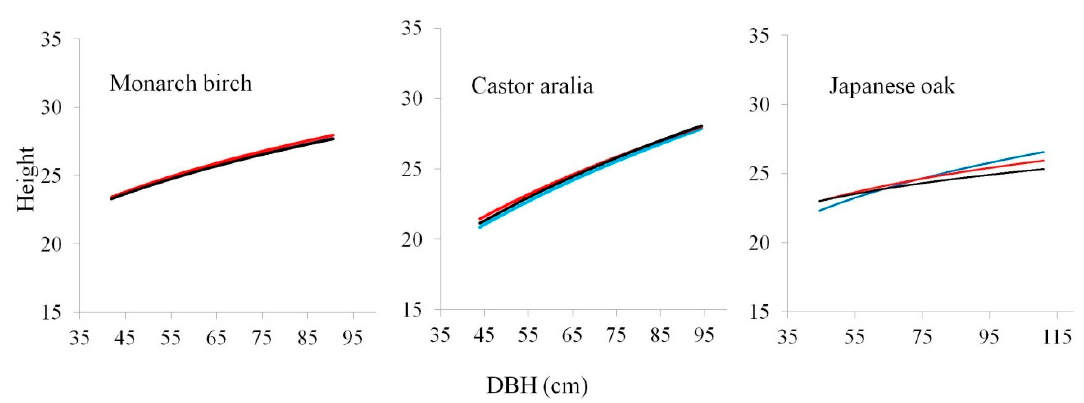
Figure 8. Height-Diameter curves. Blue, red, and black lines represent field measured height, predicted LiDAR height, and predicted UAV-DAP height, respectively.